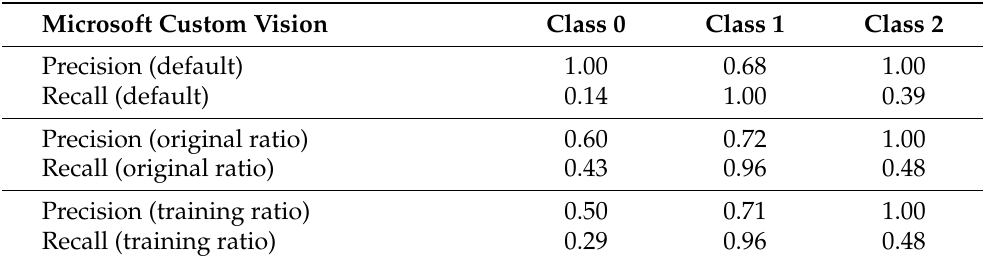
Table 12. Precision and recall per class for the Microsoft Custom Vision model on the validation set with different correction vectors.